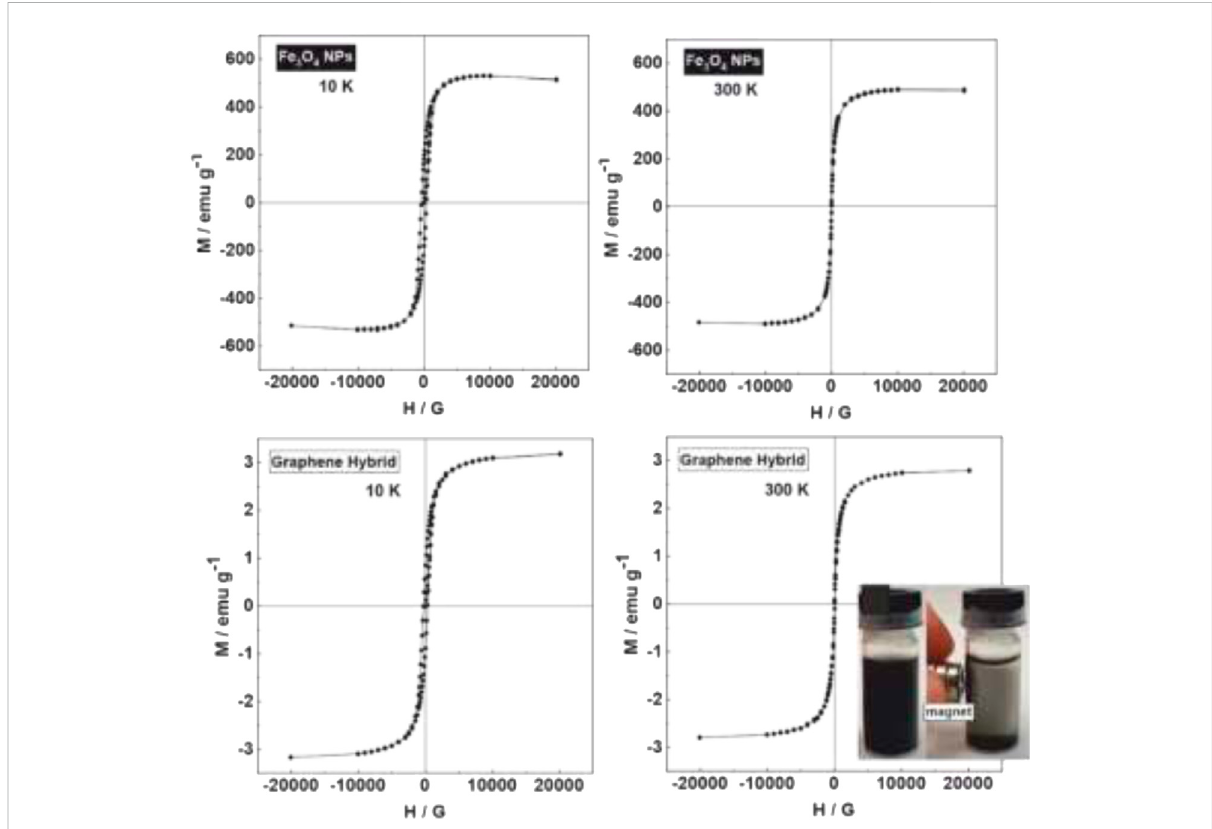
FIGURE 3 Magnetic behaviour of the graphene hybrid nanostructures dispersed in H 2 O and its response to a permanent magnet. SQUID hysteresis loops fromFe